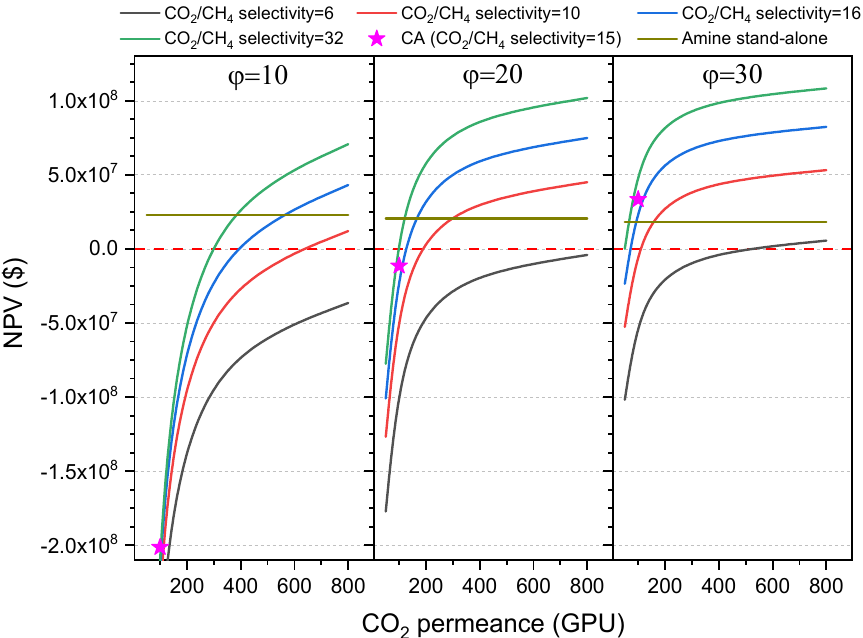
Figure 7. Effect of CO 2 permeance on net present value (NPV) of the hybrid process at CO 2 /CH 4 selectivity of 6 (black lines), 10 (red lines), 16 (blue lines) and 32 (green lines) and pressure ratio of 10 (left part), 20 (middle part), and 30 (right part). NPV values are compared to the value of the amine stand-alone process (horizontal dark yellow line) and hybrid process using the CA membrane (pink star symbol).